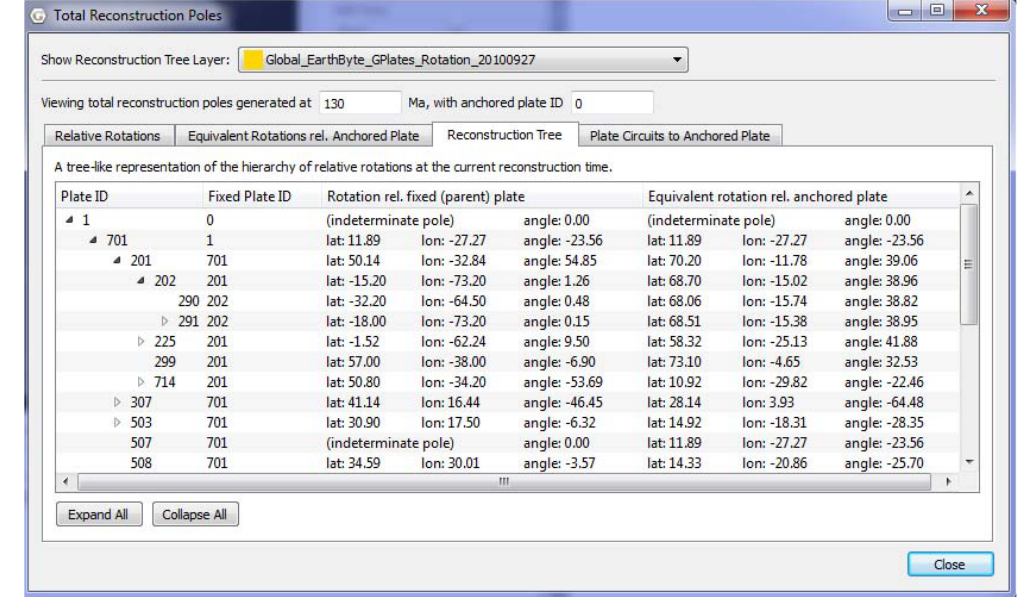
Fig. 24. The screenshot of GPlates reconstruction tree dialog.